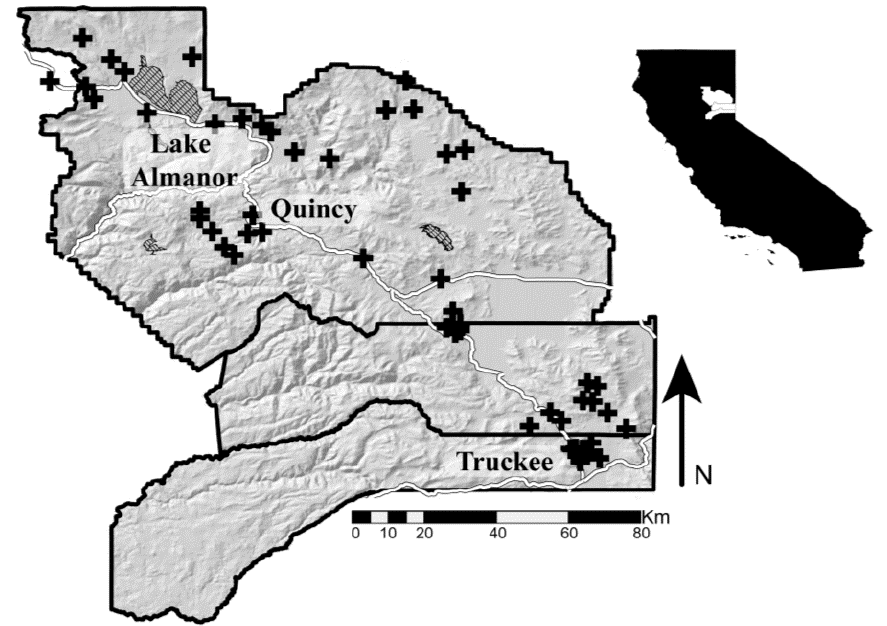
Figure 1. Study area in the northern Sierra Nevada and southern Cascades, CA. Black crosses indicate study site